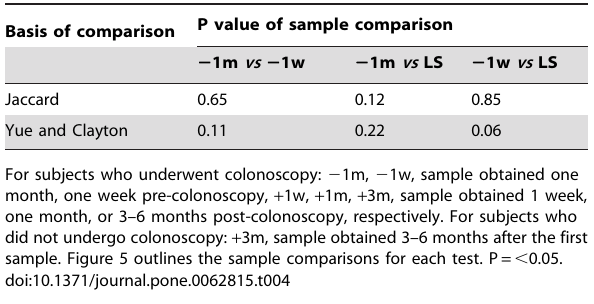
Table 4. Comparison of the mean distances between samples observed in the presence/absence (Jaccard) or relative abundance (Yue and Clayton) NMDS plots using matched pairs t